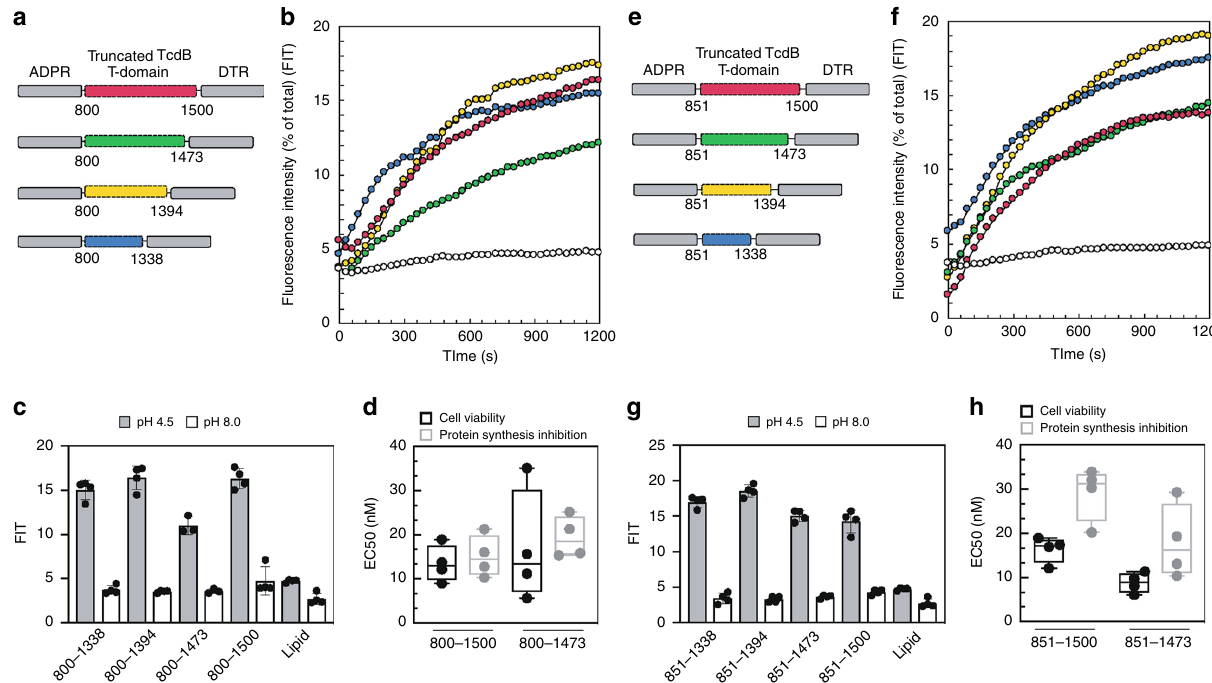
Fig. 5 De fi ning the evolutionarily conserved and minimal LCT translocase region. a Construct design of ADPR-[truncated TcdB T-domain]-DTR chimeras. b Dye release from HPTS/DPX loaded liposomes at pH 4.5, with truncated TcdB T-domains colored as follows: 800 – 1500 (red), 800 – 1473 (green), 800 – 1394 (yellow), and 800 – 1338 (blue). c Quanti fi cation of dye release from HPTS/DPX loaded liposomes after 20 min, at pH 4.5 and pH 8.0 ( N = 3). d Box plot of EC 50 values from cell viability and protein synthesis inhibition of Vero cells ( N = 4), where center line is the median, bounds of box represent the interquartile range, and the wiskers represent the minimum and maximum of data. Panels e – h the same as a – d , respectively, but with truncated TcdB T-domains 851 – 1500 (red), 851 – 1473 (green), 851 – 1394 (yellow), and 851 – 1338 (blue). Source data are provided as a Source Data File for Fig. 5 c , g , d , h